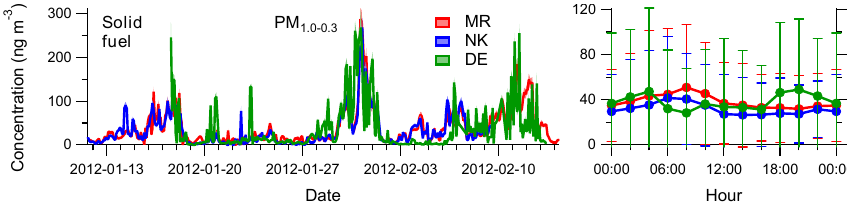
Figure 12. Time series (left) and diurnal variations (right) of the solid fuel factor at MR, NK and DE for PM 1 . 0–0 . 3 . Time series show the mean of all good solutions ± 1SD as shaded areas. Diurnals show the mean of the time series ± 1SD as whiskers, with the hour being the start of a 2h sampling period (00:00UTC means sampling from 00:00 to 02:00UTC).